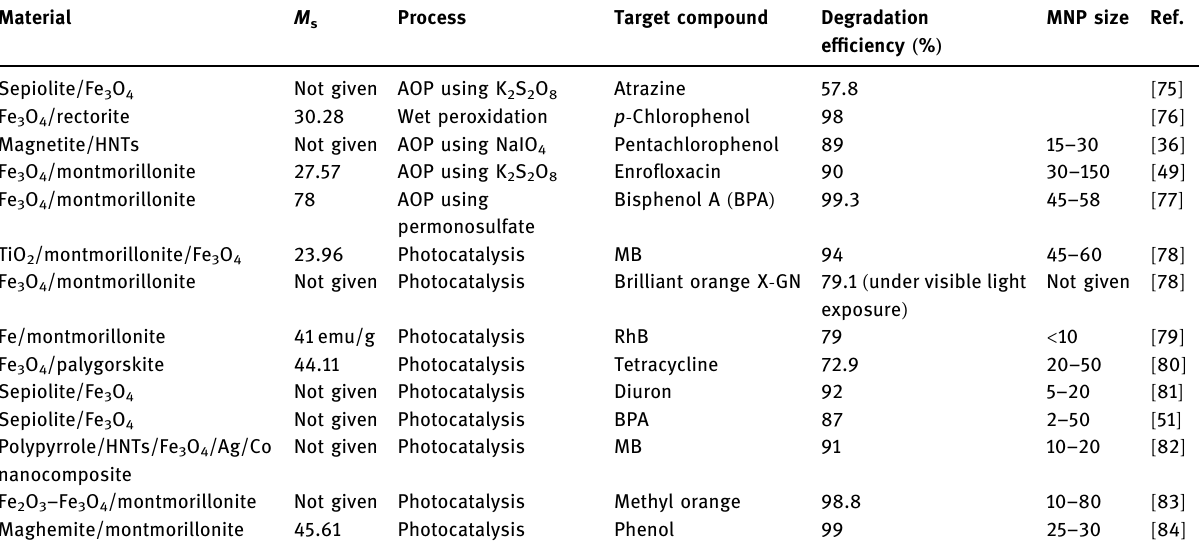
Table 3: MICNCs for the photocatalytic degradation of organic compounds